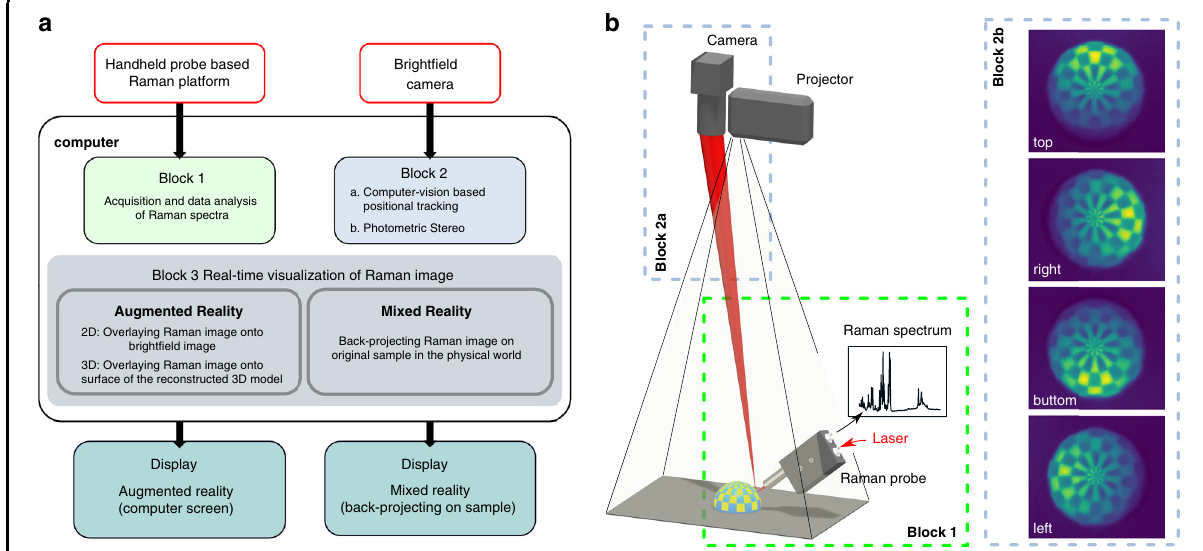
Fig. 3 Data- fl ow (a) and diagram (b) of the developed approach. Raman spectra are acquired with a handheld Raman probe (Block 1) and positional information where the spectra were acquired is determined in parallel through a bright fi eld camera (Block 2a). The Raman spectra are processed in real-time and combined with the positional information to reconstruct the Raman image, forming the molecular virtual reality visualization of the molecular distribution. Furthermore, a computer vision-based 3D surface reconstruction method (Block 2b), i.e., photometric stereo, is used to construct a 3D height map of the sample surface, allowing to overlay the reconstructed Raman image on the 3D map for a 3D visualization of the molecular